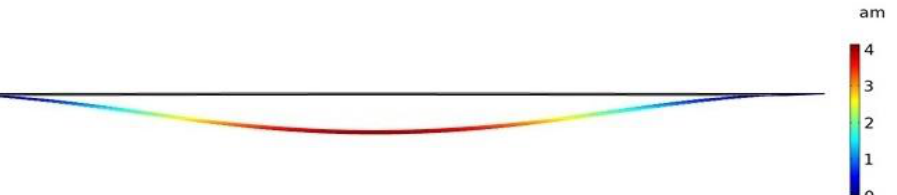
Figure 13. Deformation in a simulated profile for a silicon microbridge when width, length, and thickness are 20 µm, 40 µm, and 0.5 µm, respectively. Maximum deflection of about 4 am is obtained in the middle of the structure, when the microbridge has a 500 nm cavity height while biased with 20 V DC .